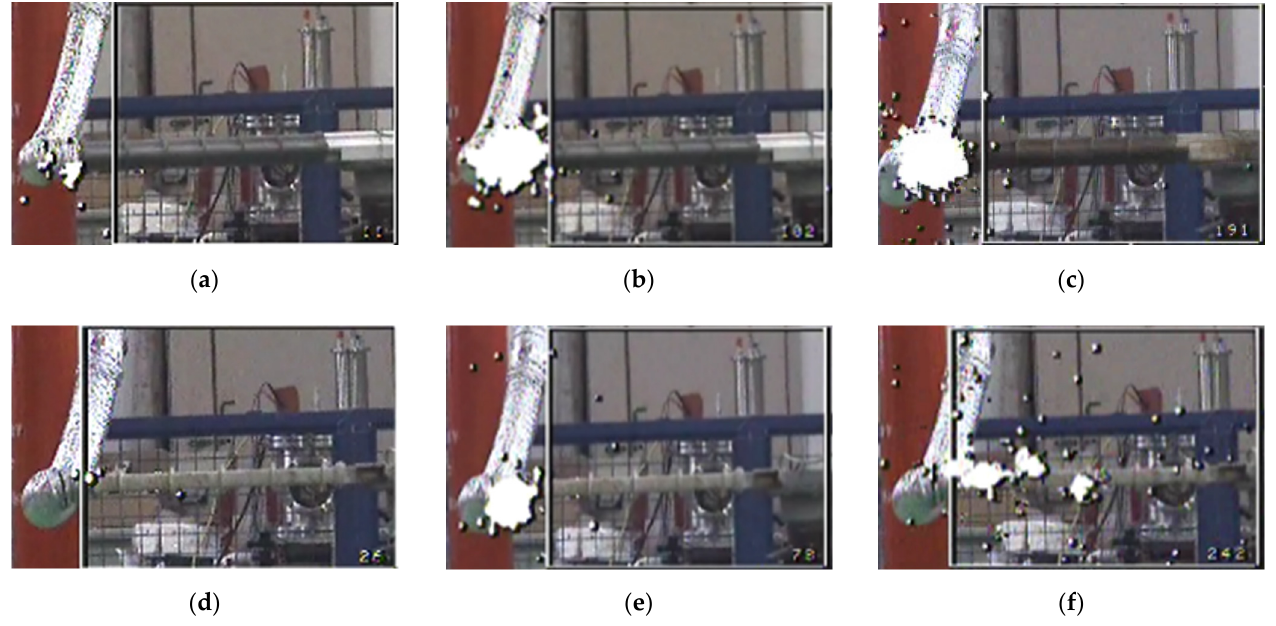
Figure 6. Observation diagram of ultraviolet camera for artificial pollution flashover test of composite cross arm: ( a ) T-unaged; ( b ) T-1; ( c ) T-2; ( d ) S-unaged; ( e ) S-1; ( f ) S-2.